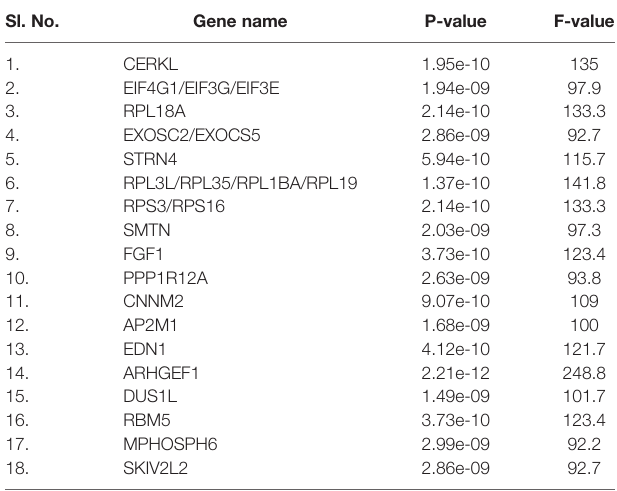
TABLE 3 | Signi fi cantly upregulated protein-coding genes DEGs from three experimental human groups of our dataset. Sl. No.